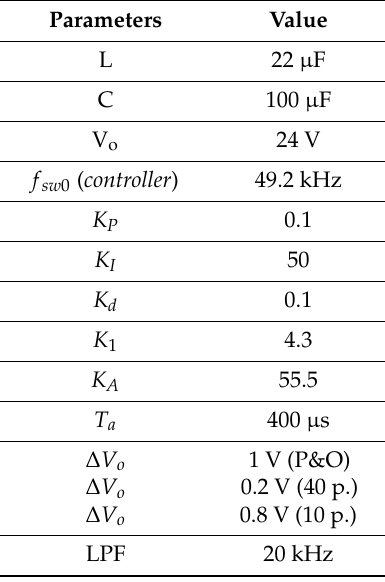
Table 2. Parameters of controller, converter and